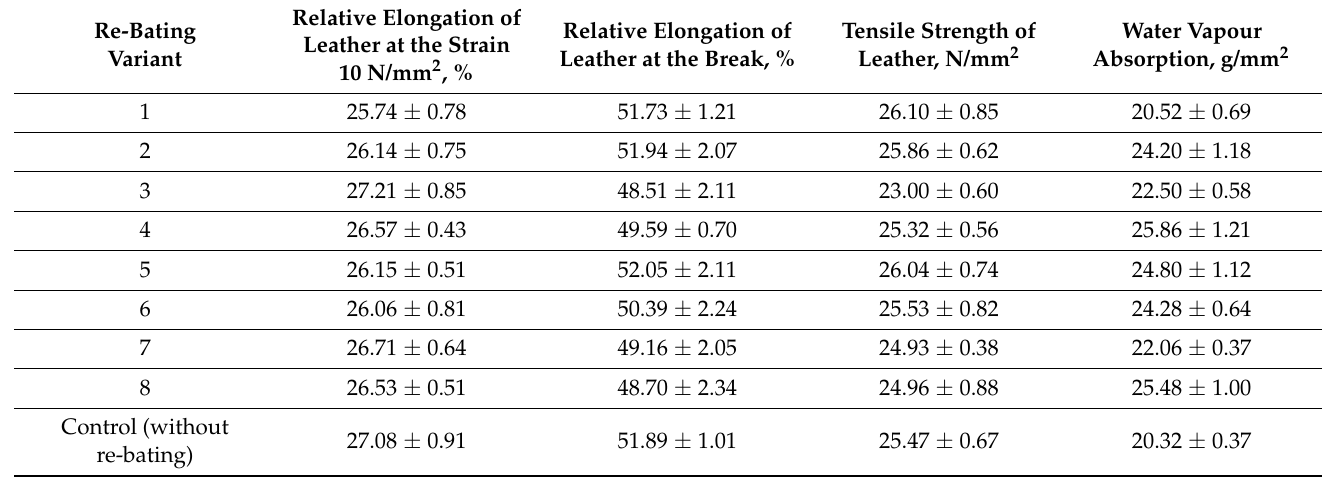
Table 4. Physical and mechanical properties of WB after treatment with